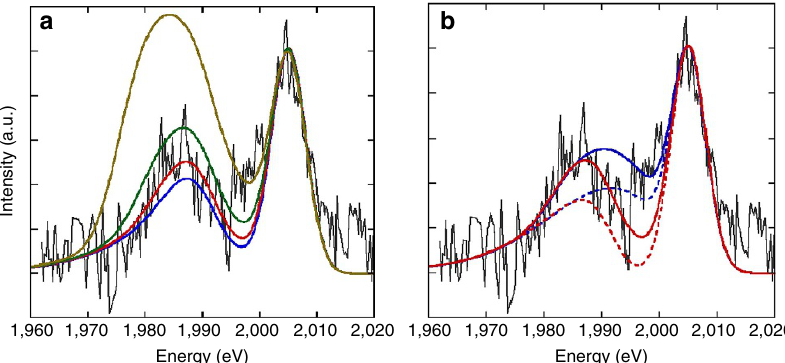
Figure 5 | Measured backscattering spectrum with theoretical fits. Fits are shown for target conditions of T e ¼ 0.15eVand r / r 0 ¼ 3.2. ( a ) Four ionization states corresponding to Z ¼ 0.1 (blue), 0.15 (red), 0.25 (green) and 0.5 (yellow) are shown, with a best fit found for n e ¼ 2.4 (cid:3) 10 22 cm (cid:2) 3 and Z ¼ 0.15 ± 0.08. ( b ) Theoretical fits for Z ¼ 0.15 using the SP (red) and EK (blue) models for ionization potential depression. Solid lines correspond to the total spectrum and dashed to the elastic and bound-free scattering contributions without free–free scattering. Both models result in best fit values for ionization of Z ¼ 0.15.